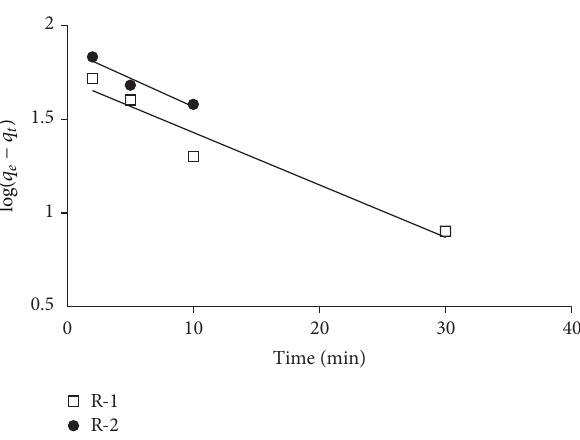
Figure 3: Effect of time on adsorption process. Figure 4: The pseudo-first-order kinetics model.